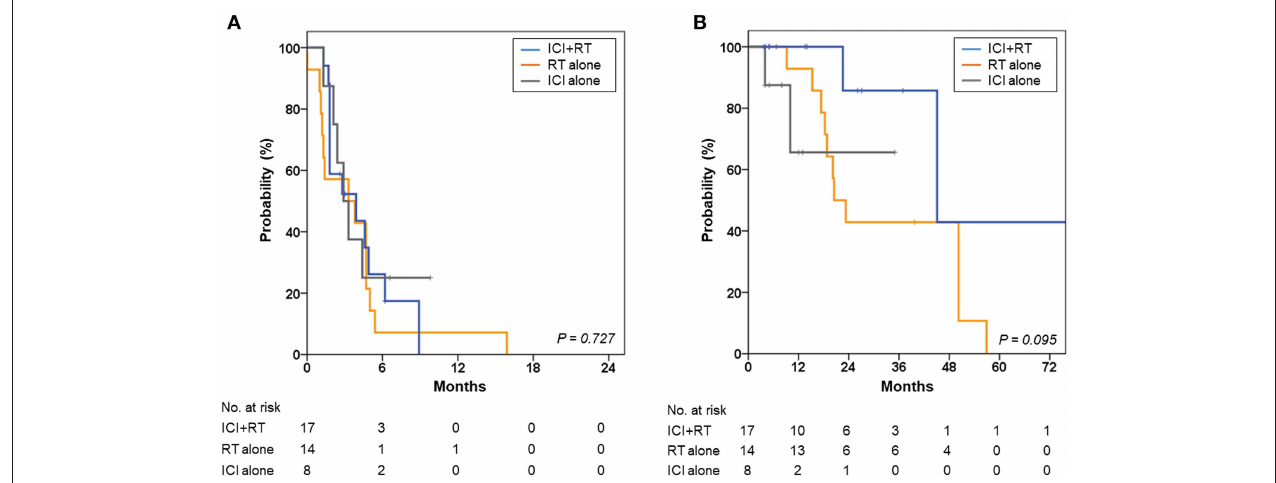
FIGURE 4 | Kaplan-Meier curves for (A) progression-free survival and (B) overall survival of the ICI + RT, RT alone, and ICI alone groups. ICI, immune checkpoint inhibitors; RT, radiotherapy; ICI + RT, pembrolizumab combined with RT.